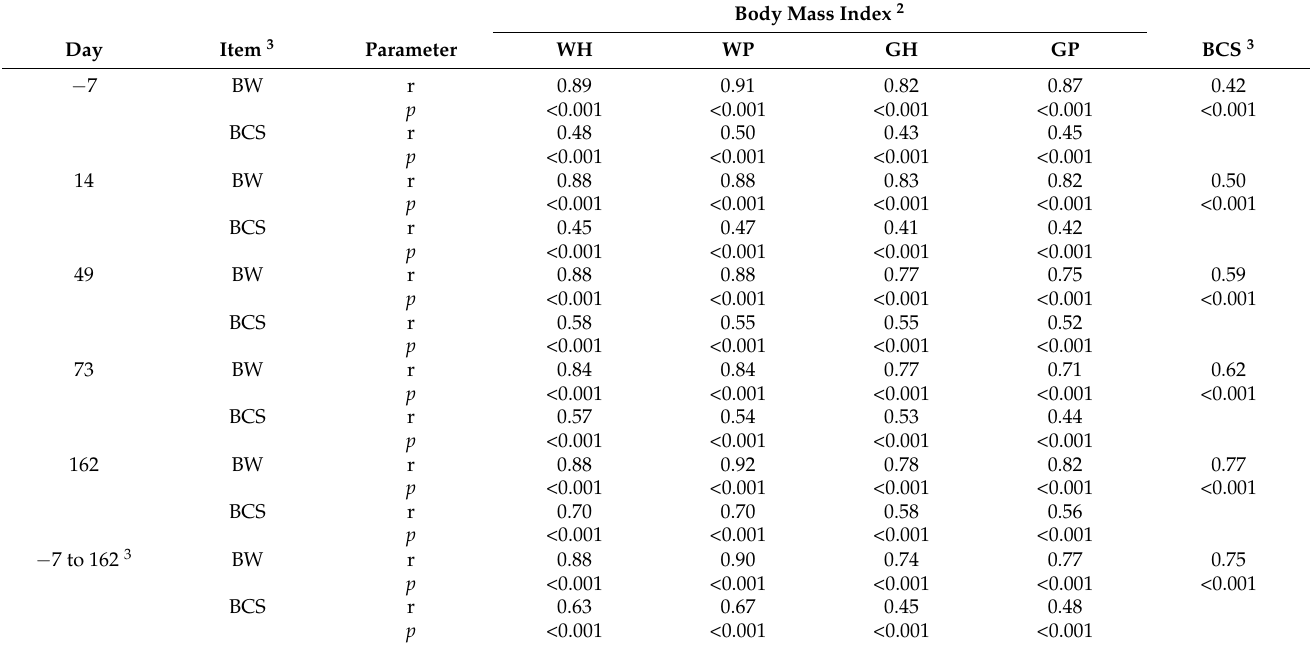
Table 10. Correlation coefficients (r) between body mass indexes and body weight and body condition score at different times and change during the supplementation phase of hair sheep 1